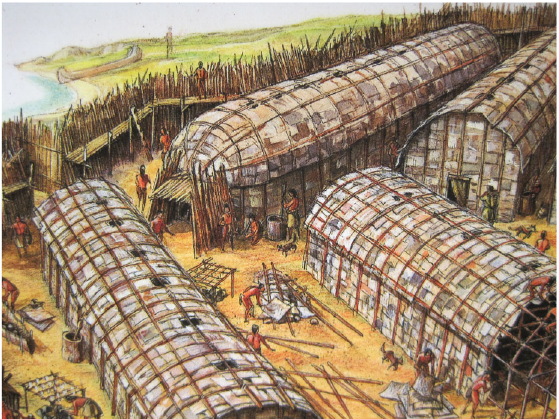
Fig. 2 An Iroquois village showing longhouses. The member tribes of the Iroquois Confederacy, which lasted over 300 years, gave up warring with one another. The revered peacemaker-prophet named Diganawidah is reputed to have drawn an analogy between the families of a longhouse living harmoniously under one shared roof and the tribes of the confederacy living in unity and peace under the law. Reproduced with permission